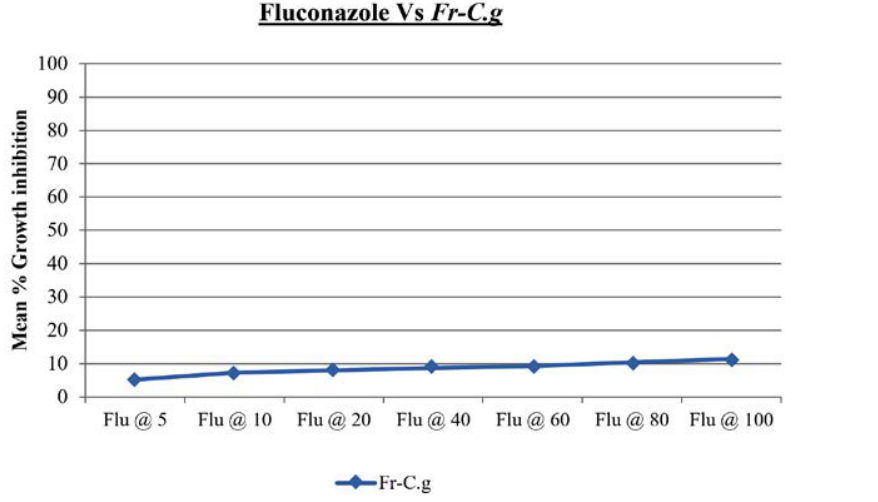
Fig. 4. Minimum percentage Growth Inhibition of Fluconazole resistant Candida